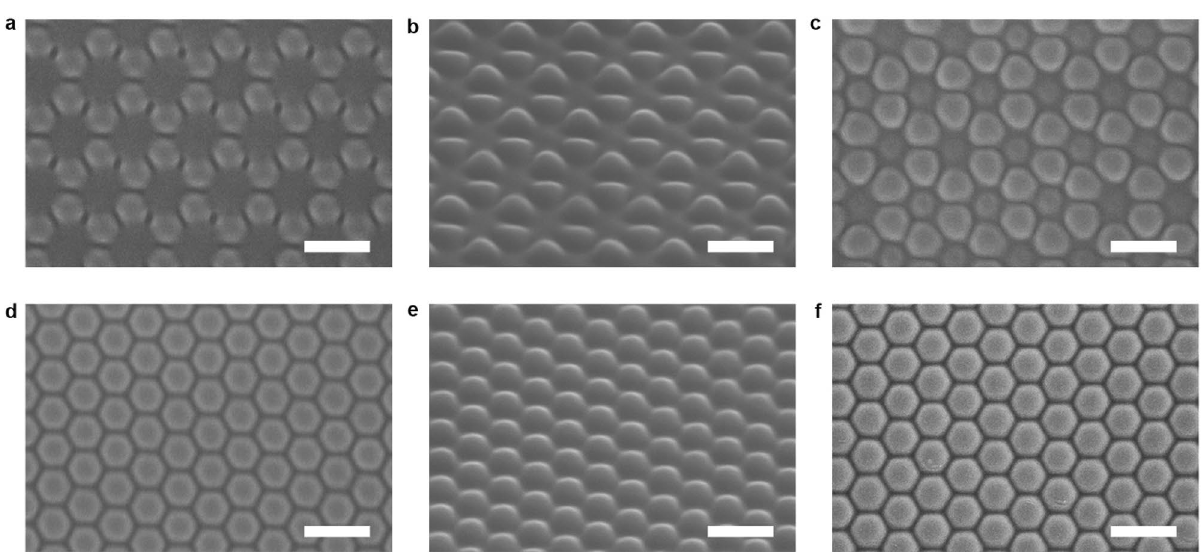
Figure 6. Typical SEM images of the IA-Chol submicron pillar arrays after irradiation with the right-hand circularly polarized light for different time periods. ( a ) Top-view SEM image of the array after being irradiated for 14 min. ( b ) Side-view SEM image corresponding to panel ( a ). ( c ) Top-view SEM image of the array after being irradiated for 25 min. ( d ) Top-view SEM image of the array after being irradiated for 30 min. ( e ) Side-view SEM image corresponding to panel ( d ). ( f ) Top-view SEM image of the array after being irradiated for 60 min. The light intensity was 300 mW cm −2 . The scale bars of all the SEM images correspond to 1